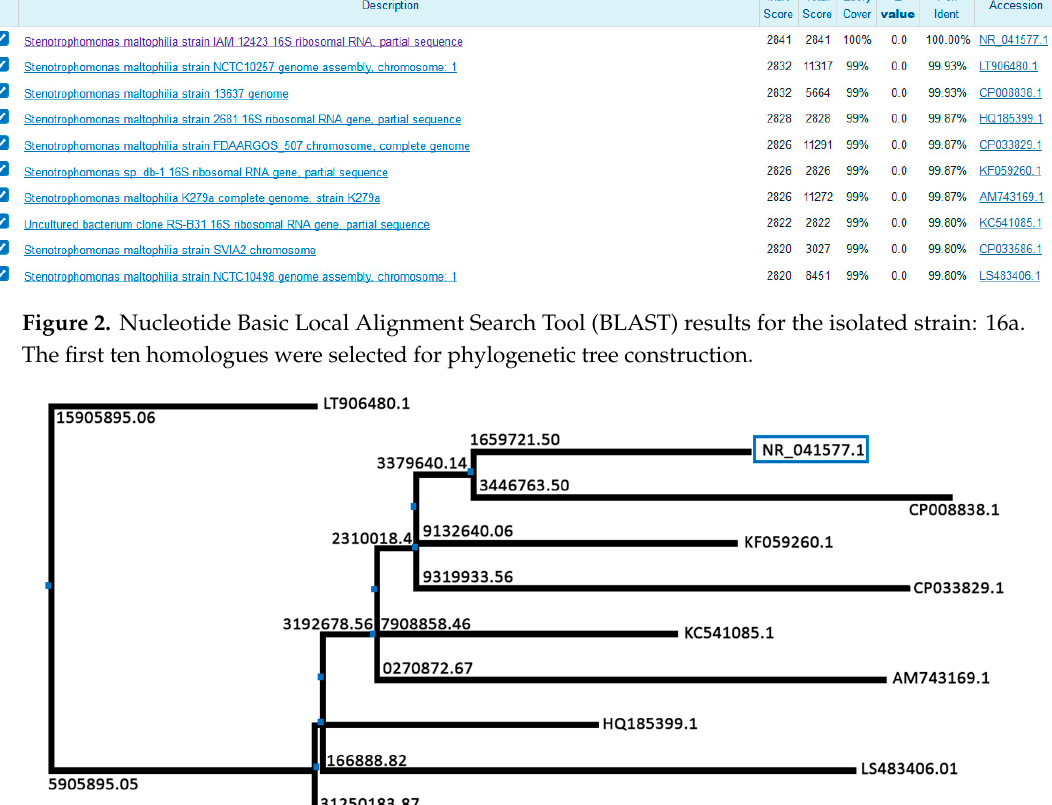
Figure 3. An illustration of the neighbor-joining phylogenetic tree of identified isolate 16a: Stenotrophomonas maltophilia strain IAM 12423 . The numbers indicate the evolutionary distance, whereas the labels at the end of the arms represent the accession numbers of the BLAST homologues. The blue pointers indicate nodes.